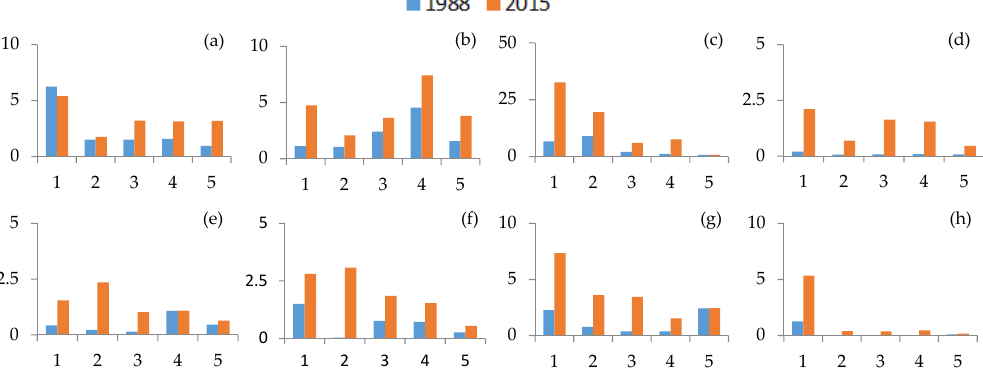
Figure 8. LPIs of the bays in 1988 and 2015. ( a ) Hai Loc Bay; ( b ) Dam Ha Trung Bay; ( c ) Danang Bay; ( d ) Xuan Dai Bay; ( e ) Vinh Van Phong Bay; ( f ) Cam Ranh Bay; ( g ) Ganh Rai Bay; and ( h ) R ạ ch Giá